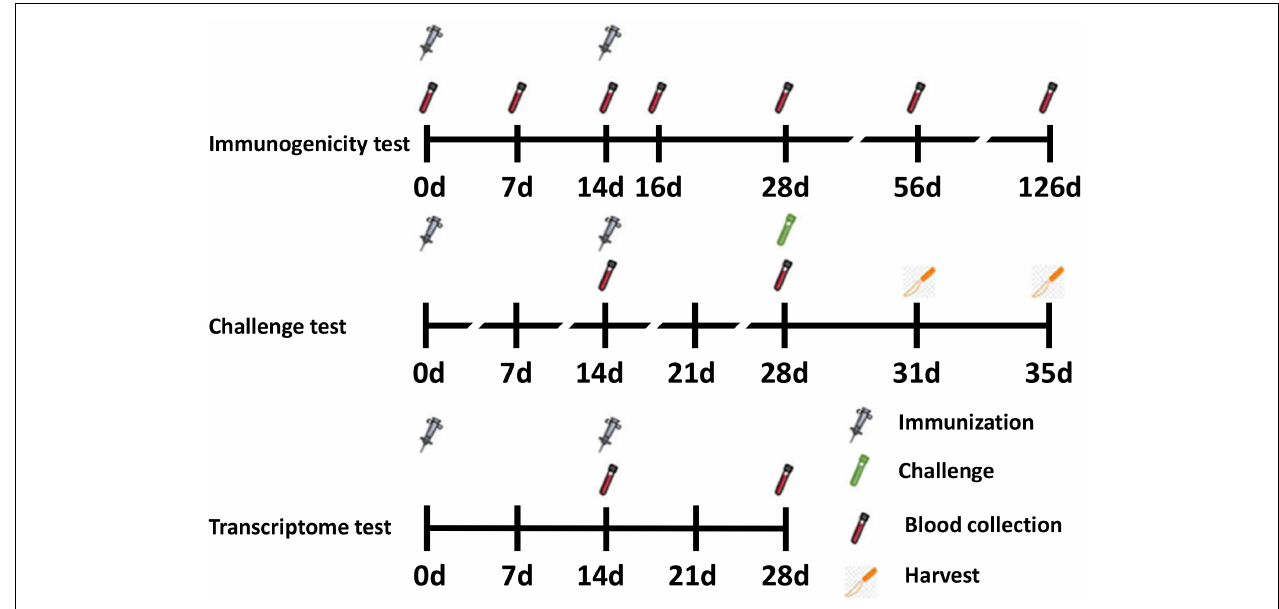
FIGURE 1 | Timeline for vaccination, challenge, blood, and tissue sampling schedules.